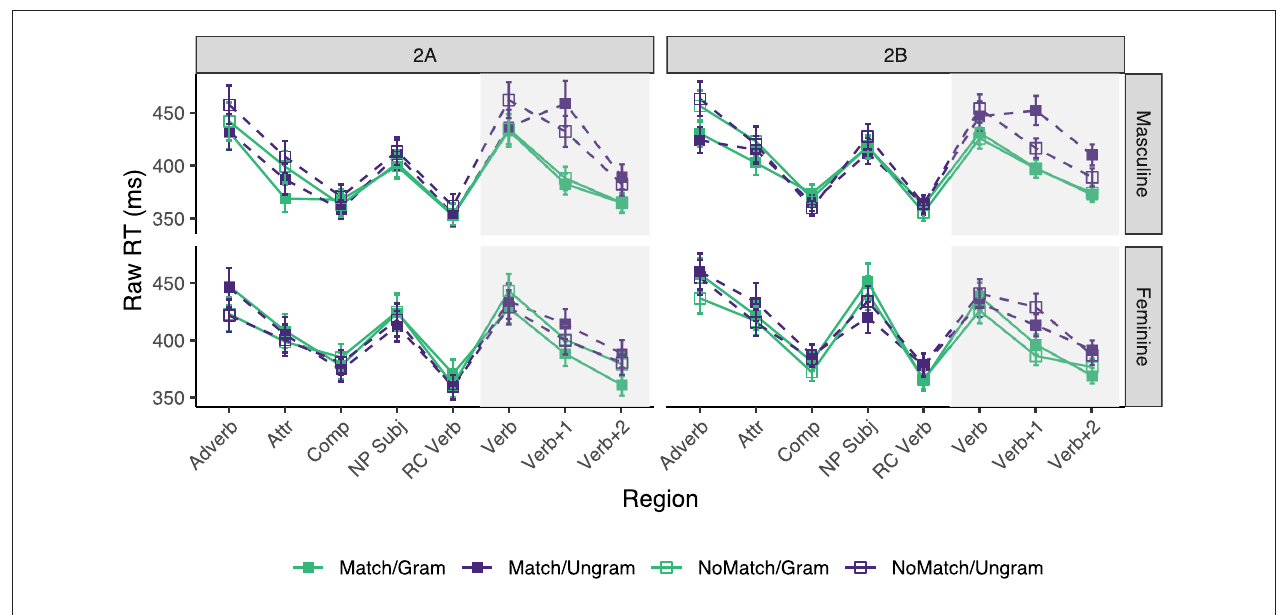
Figure 2 | Mean raw reading times from Experiment 2 for all conditions and regions by SUBJECT GENDER . Error bars represent the standard error of the condition mean across participant averages.